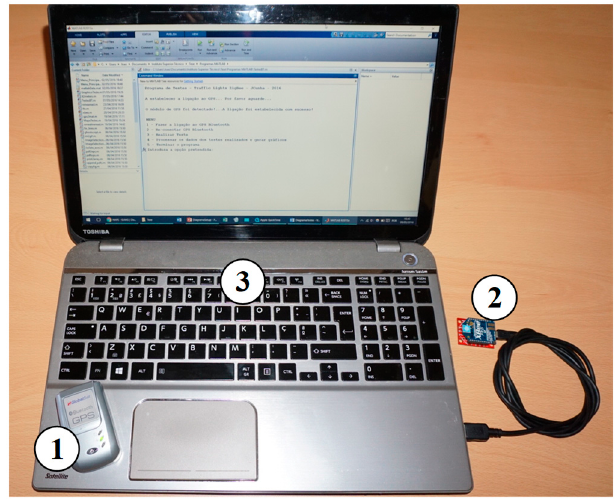
Figure 8. Components of the mobile system.